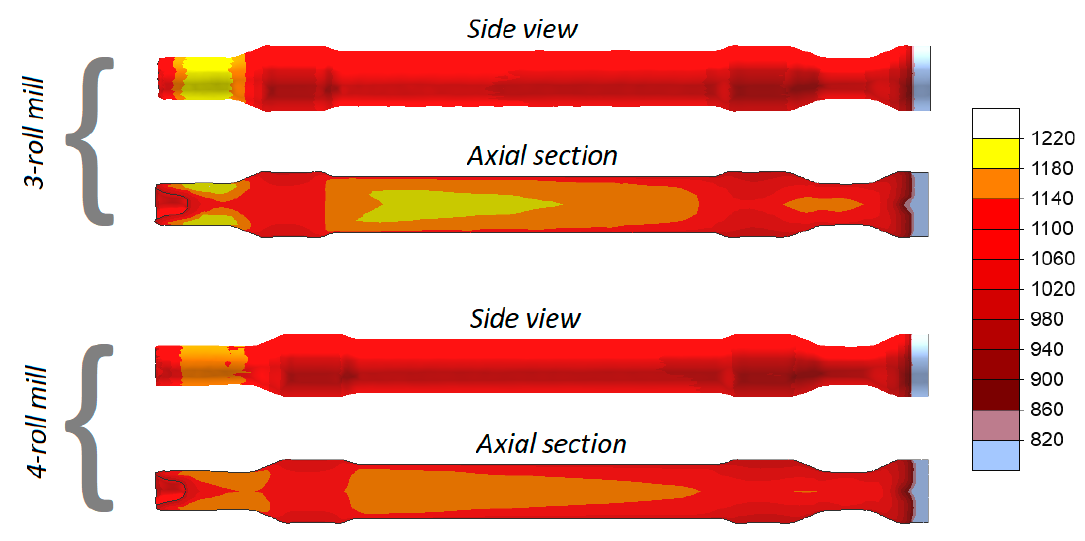
Figure 7. Temperatures (°C) in skew-rolled axles.